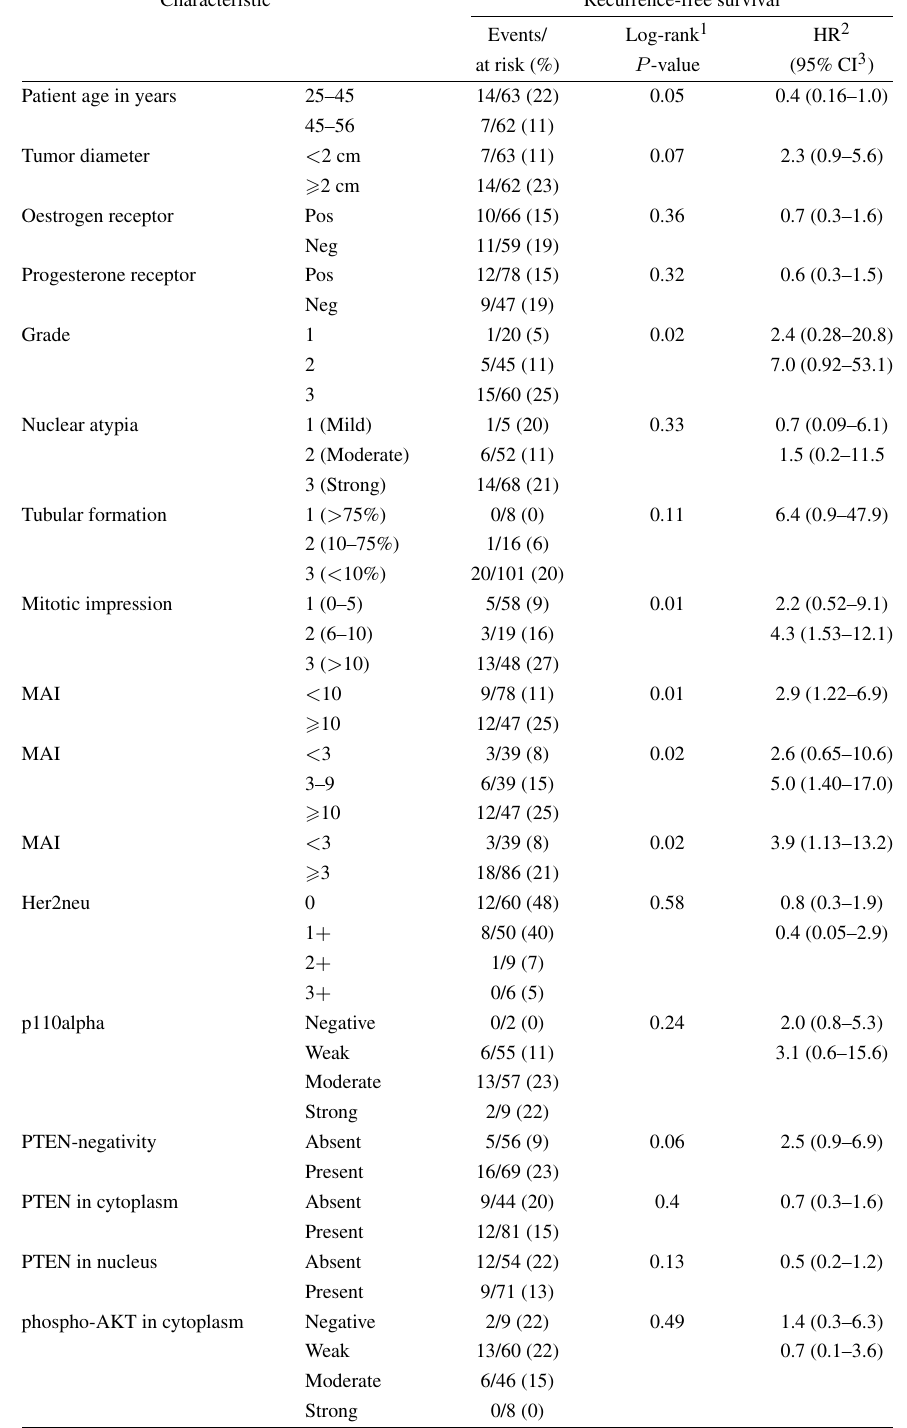
Characteristics of patients and tumors in relation to recurrence-free survival